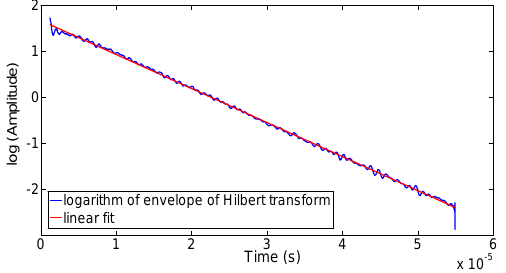
Figure 4. A fit of an exponential function to the envelopes of a monochromatic signal (obtained by a Hilbert transform). The decay constant is obtained from the fit.